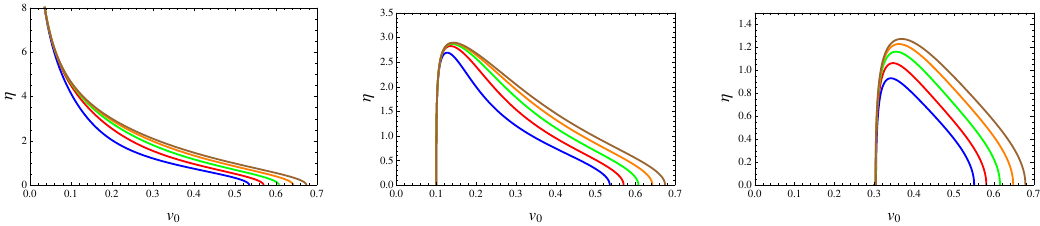
Figure 2 . Chirally broken pro(cid:12)les characterized by (cid:17) ( v 0 ) for di(cid:11)erent values of the magnetic (cid:12)eld b = 0 : 1 (blue), b = 0 : 2 (red), b = 0 : 3 (green), b = 0 : 4 (orange) and b = 0 : 5 (brown). The left, center and right panels correspond to v T = 0, v T = 0 : 1 and v T = 0 : 3, respectively.